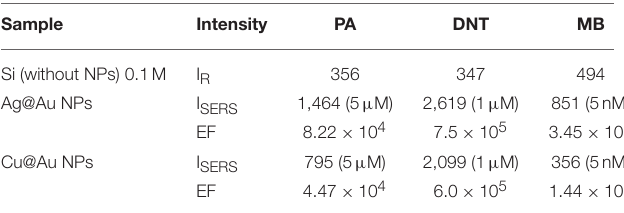
TABLE 1 | Raman intensity obtained from SERS measurements and calculation of EF. Sample Intensity PA DNT